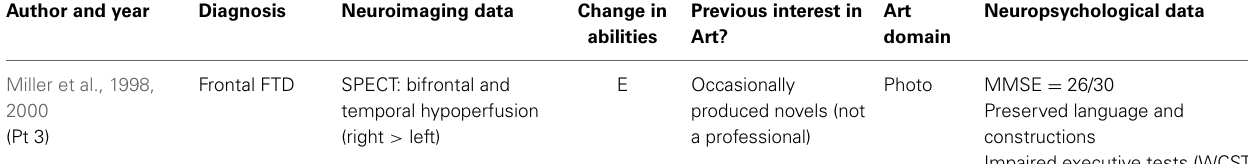
Table 1 | Synthesis of published articles reporting changes in artistic creativity in neurological